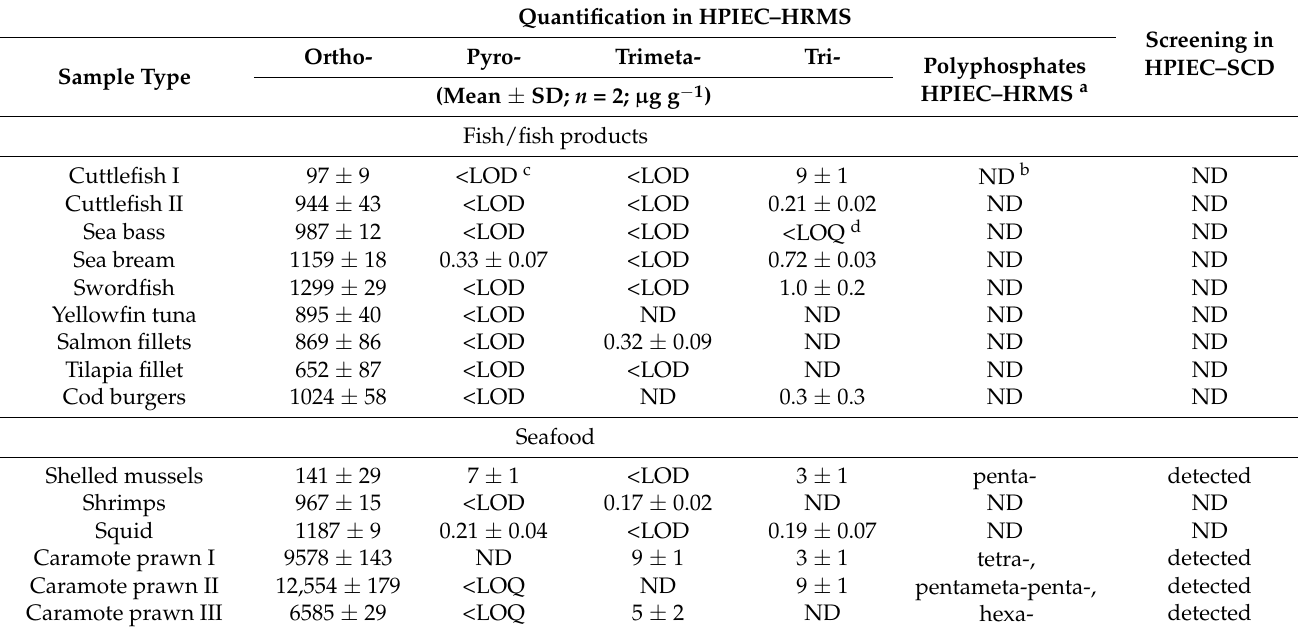
Table 4. (Poly)phosphates in different types of undeclared fish/seafood products.